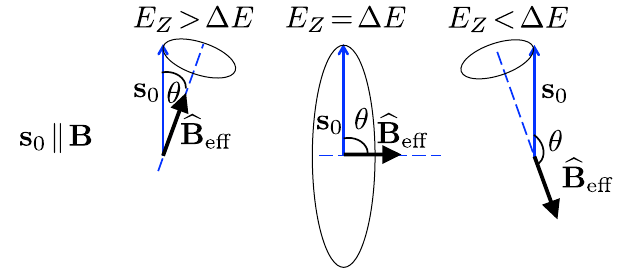
FIG. 3. The injected spin polarization s 0 is directed along the external in-plane magnetic field B ∥ ˆ z ; see Fig. 1. The effective magnetic field B determines the pseudospin precession eff after injection. The z component of B , Eq. (20), vanishes at eff the resonance condition, Eq. (21). At resonance, the pseu- dospin dynamics is a pure precession with a frequency contro- = ℏ Þj B lled by the SO coupling matrix element, ð g μ B eff j ¼ ð 1 = ℏ Þjh n þ 1 ; ↑ j α p z σ x j n; ↓ ij . Off resonance, a finite component of injected spin ( ∝ cos θ ) is conserved and is represented by an x -independent part in Eq.